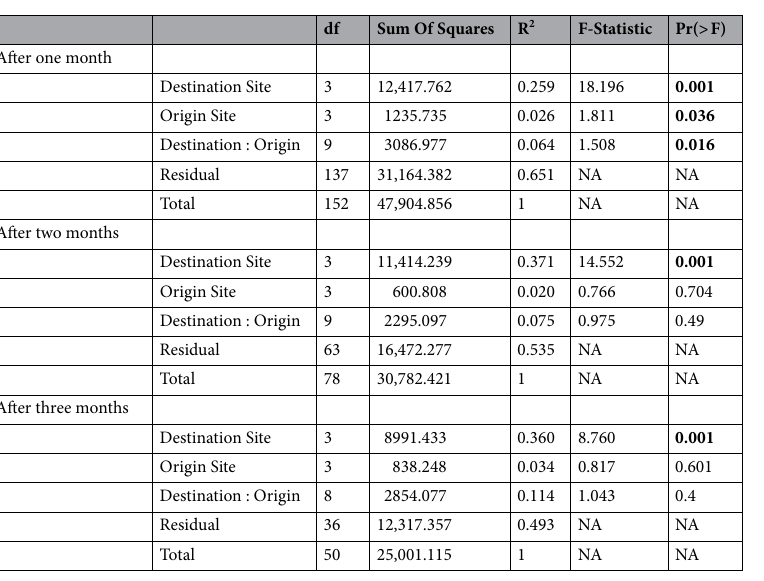
Table 3. Results of PERMANOVA showing differences among transplanted root microbial communities (see Fig. 4). Significant values are in